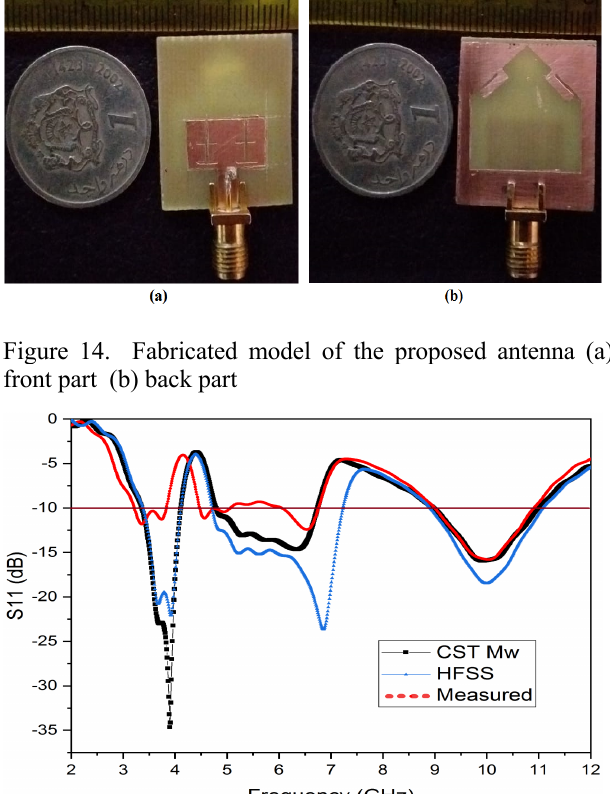
Figure 15: Comparison between the S 11 versus frequency.